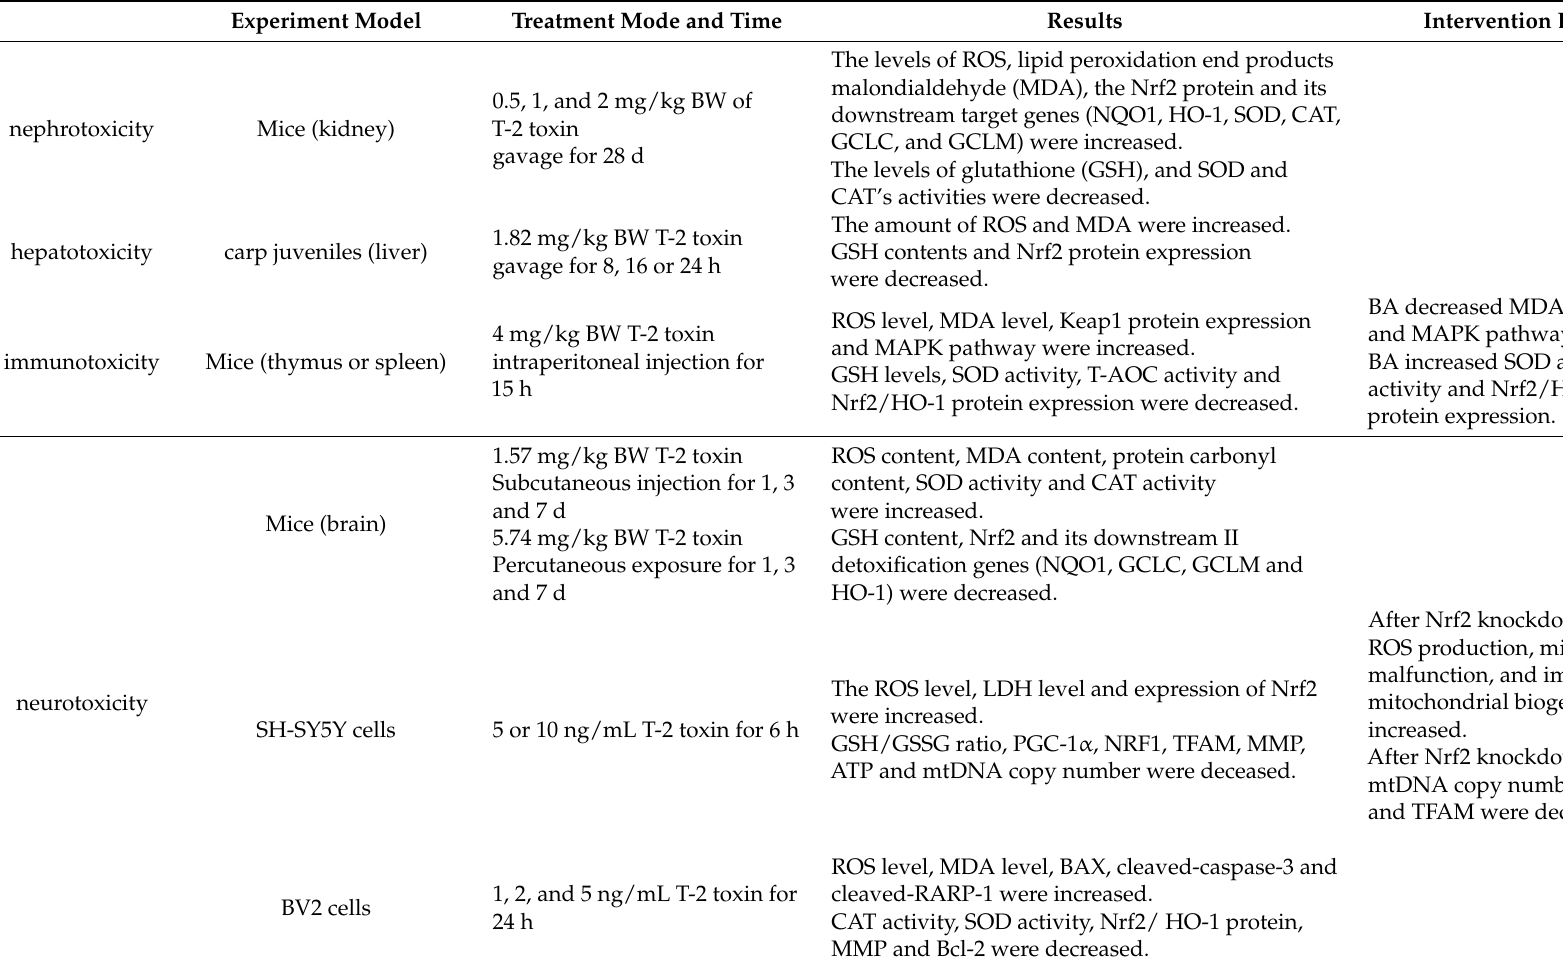
Table 2. A summary of all investigations on Nrf2 and the harmful effects of T-2 toxin